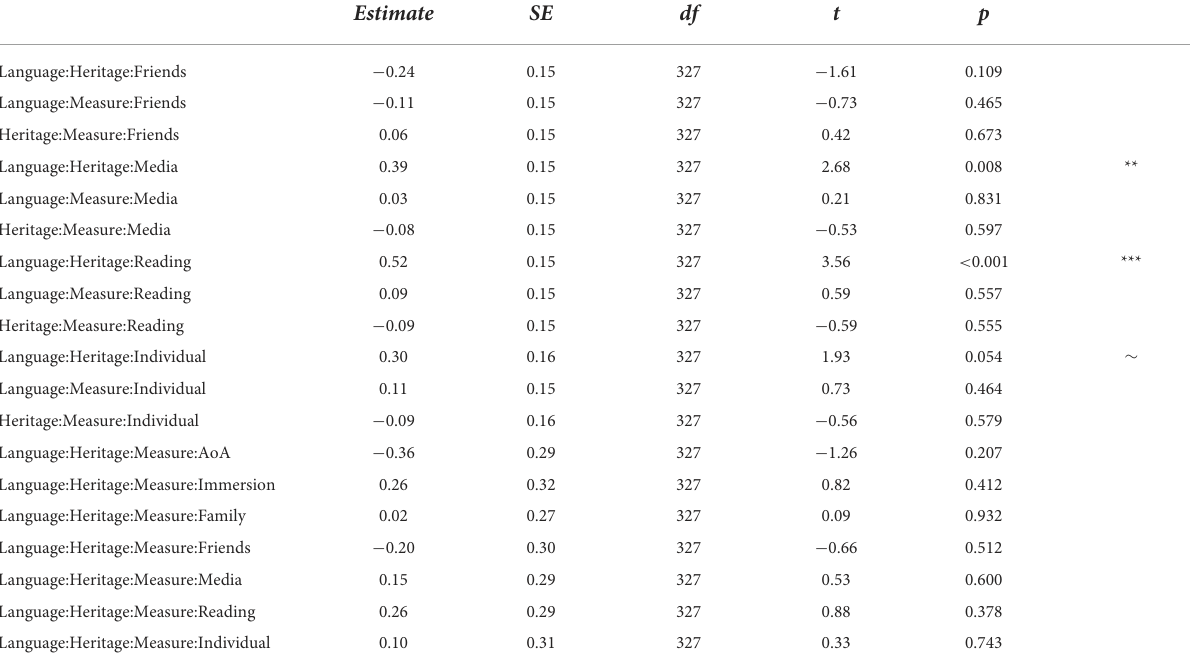
Figure 3A and Table 4 for full output). A series of three-way interactions additionally emerged for relative age of acquisition ( p < 0.001) and the composite measures for relative acquisition and exposure through family ( p = 0.007), media ( p = 0.008), and reading ( p < 0.001). Among non-Spanish bilinguals, HL proficiency was negatively predicted by more similar ages of HL and English acquisition [ Estimate = 0.60, SE = 0.14, t (151) = 4.41, p < 0.001] and relatively higher ratings of English (vs. HL) acquisition and exposure experience through family [ Estimate = − 0.50, SE = 0.13, t (151) = − 3.85, p < 0.002], media [ Estimate = − 0.52, SE = 0.14, t (151) = − 3.76, acquisition, and exposure did not predict HL